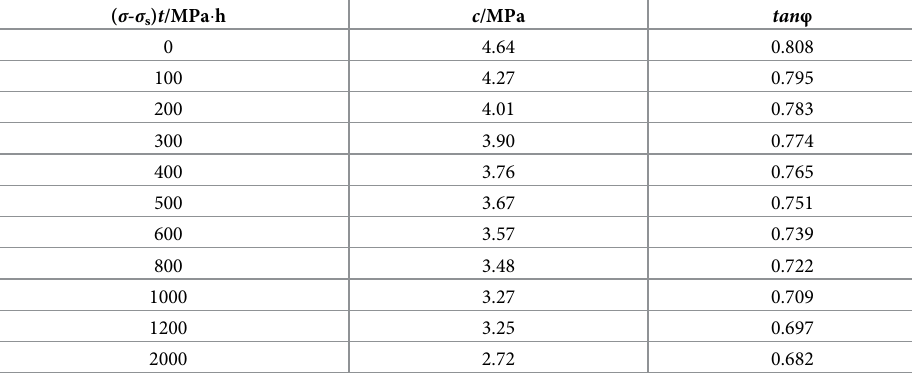
Table 1. Relationships between cohesion, internal friction coefficient and ( σ - σ s ) t